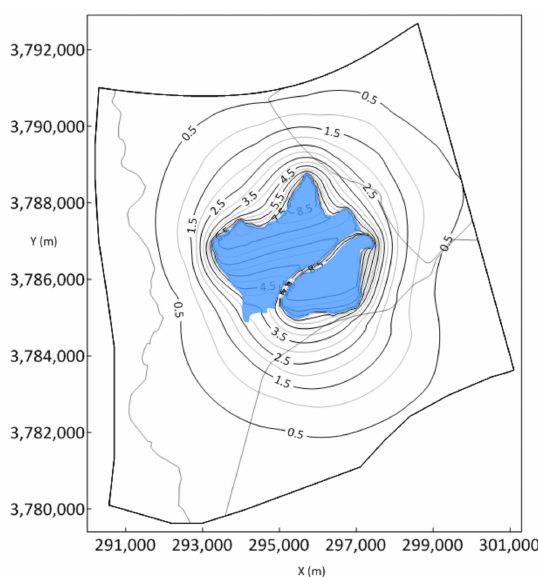
Figure 11. Comparison of groundwater flow field before and after water storage in